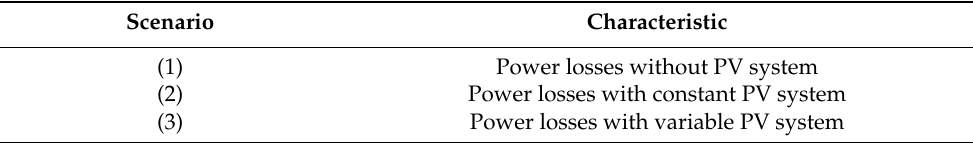
Table 5. Scenarios to quantify the reduction of energy